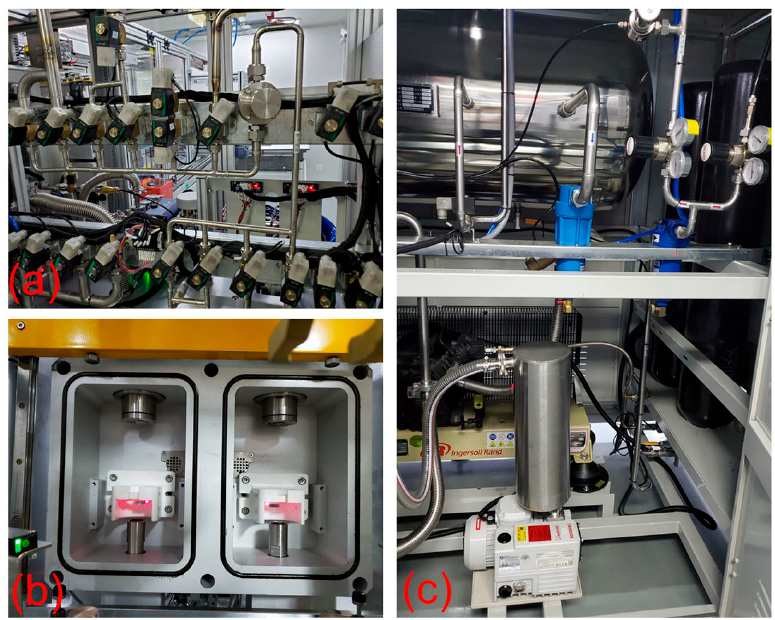
Figure 4. Helium leak test system: ( a ) Helium control valve; ( b ) vacuum test room; ( c ) helium recovery system.